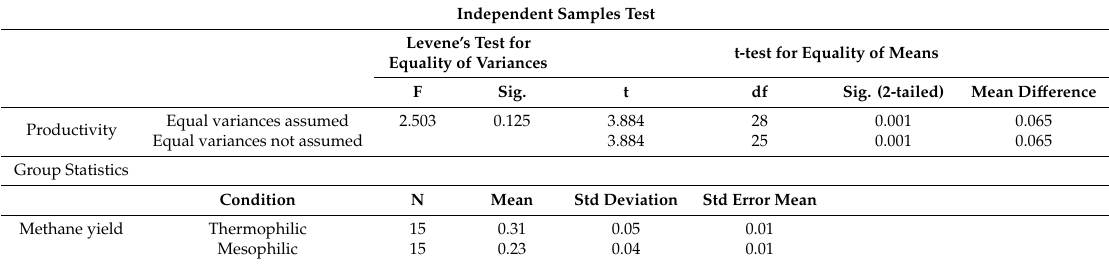
Summary of t-test for the measured methane yield between mesophilic and thermophilic